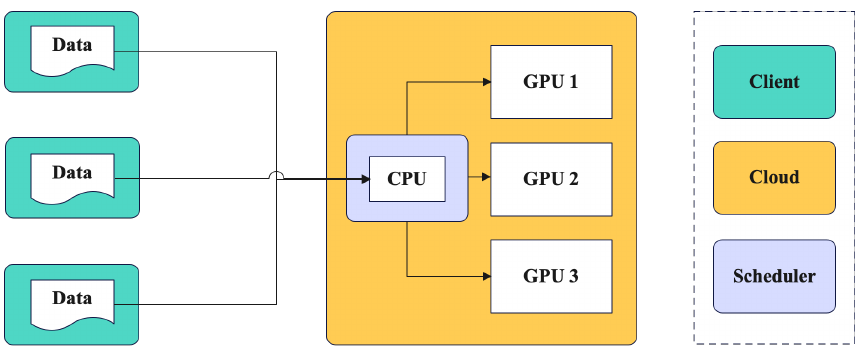
Figure 4. Illustration of the scheduling model.